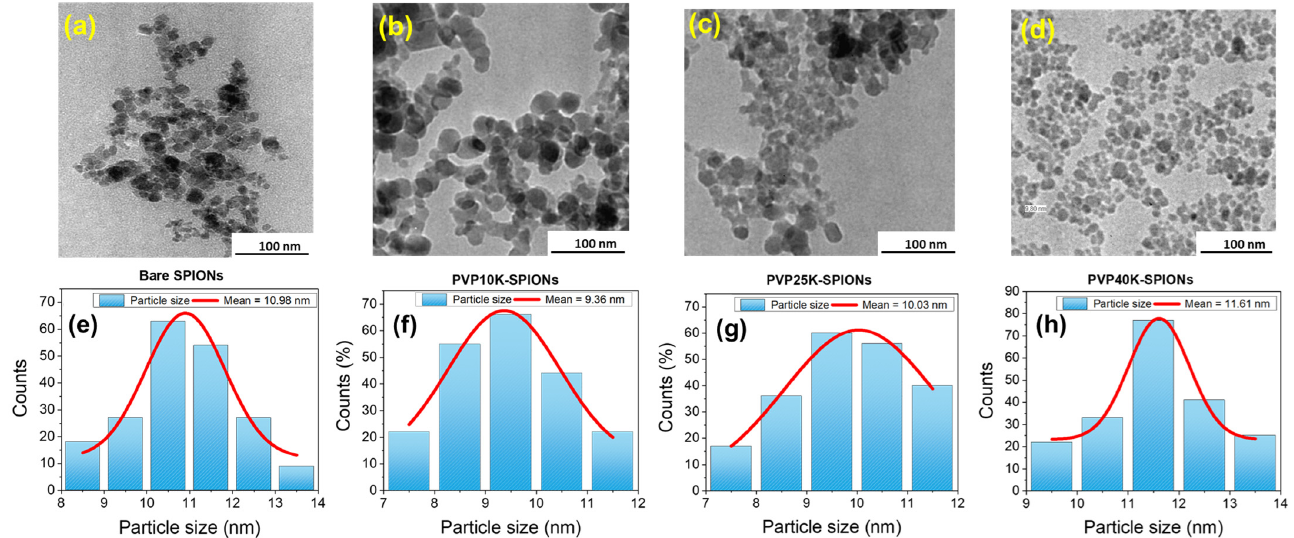
Figure 3. TEM images and size histograms analysis of bare and PVP-coated SPIONs synthesized via one-pot co-precipitation method, showing the morphological properties and size distribution of the nanoparticles. TEM images are presented in the first row ( a – d ): ( a ) bare SPIONs, ( b ) PVP10K-SPIONs, ( c ) PVP25K-SPIONs, and ( d ) PVP40K-SPIONs. Particle size distributions, measured in nanometers, are shown in the second row ( e – h ): ( e ) bare SPIONs, ( f ) PVP10K-SPIONs, ( g ) PVP25K-SPIONs, and (h) PVP40K-SPIONs.